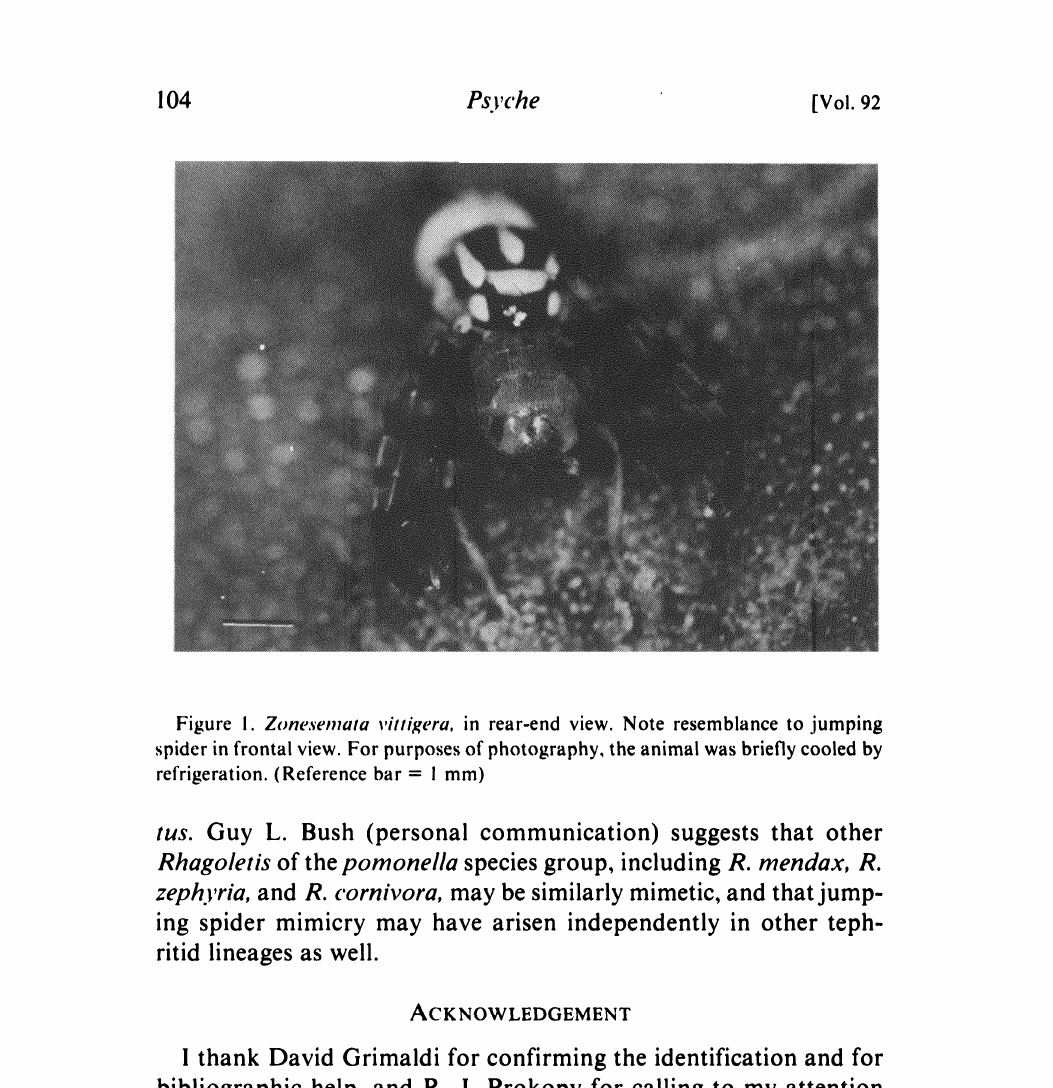
Figure I. Zonesemata vittigera, in rear-end view. Note resemblance to jumping spider in frontal view. For purposes of photography, the animal was briefly cooled by refrigeration. (Reference bar